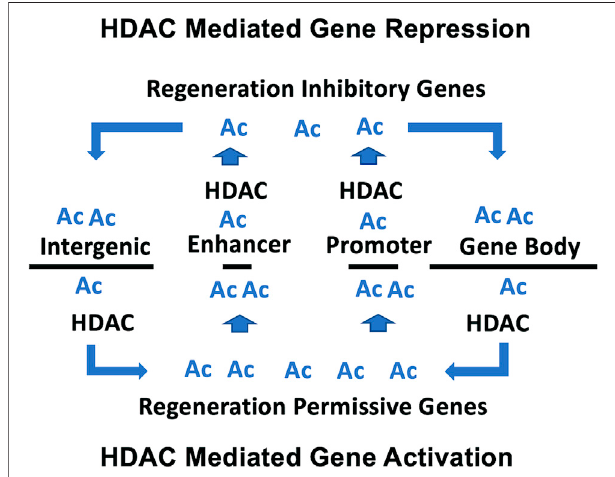
FIGURE 8 | Model proposed for HDAC-mediated transcriptional regulation during tail regeneration. For HDAC mediated gene repression, HDAC activity is associated with promotor/enhancer regions to compact chromatin and prevent accessibility of transcription promoting factors. For HDAC mediated gene activation, HDAC activity is associated with intergenic regions and gene bodies, which increases the pool of acetyl lysine residues for hyperacetylation of promotor/enhancer regions and the recruitment of transcription promoting